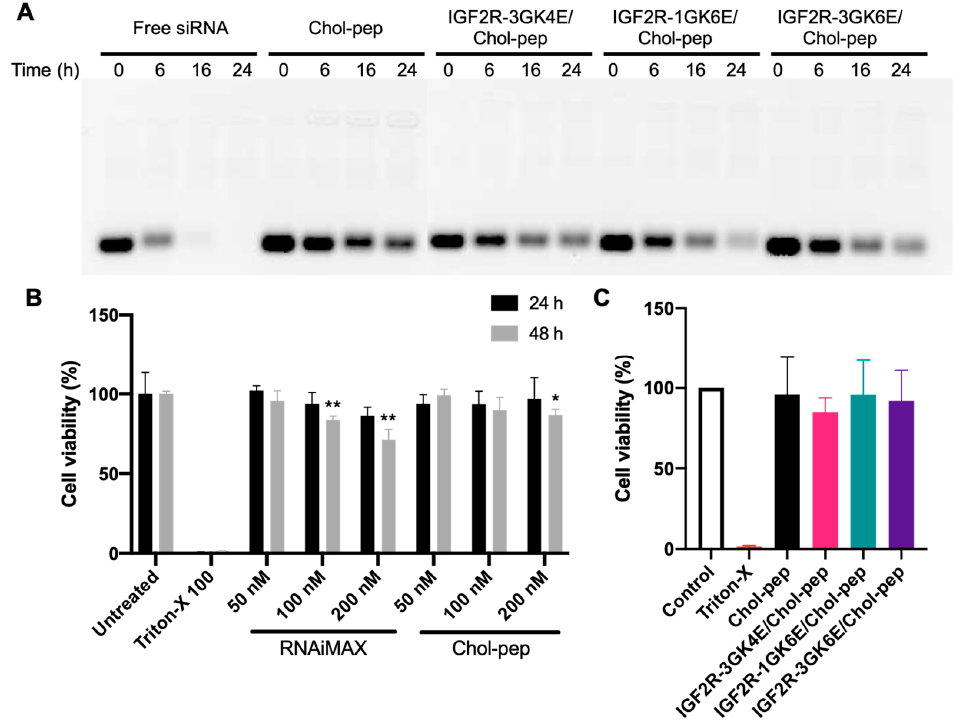
Figure 3. Serum stability and cytotoxicity of the nanocomplex. ( A ) Serum stability of siRNA nanocomplexes in 50% rat serum for 0, 6, 12, and 24 h. ( B ) Cytotoxicity of the cholesteryl peptide nanocomplexes and Lipofectamine™ RNAiMAX at 50, 100, 200 nM siRNA. ( C ) Cytotoxicity of the IGF2R peptide-modified nanocomplexes at 100 nM siRNA. Results are presented as the mean ± SD ( n = 3) (* p < 0.05; ** p < 0.01).